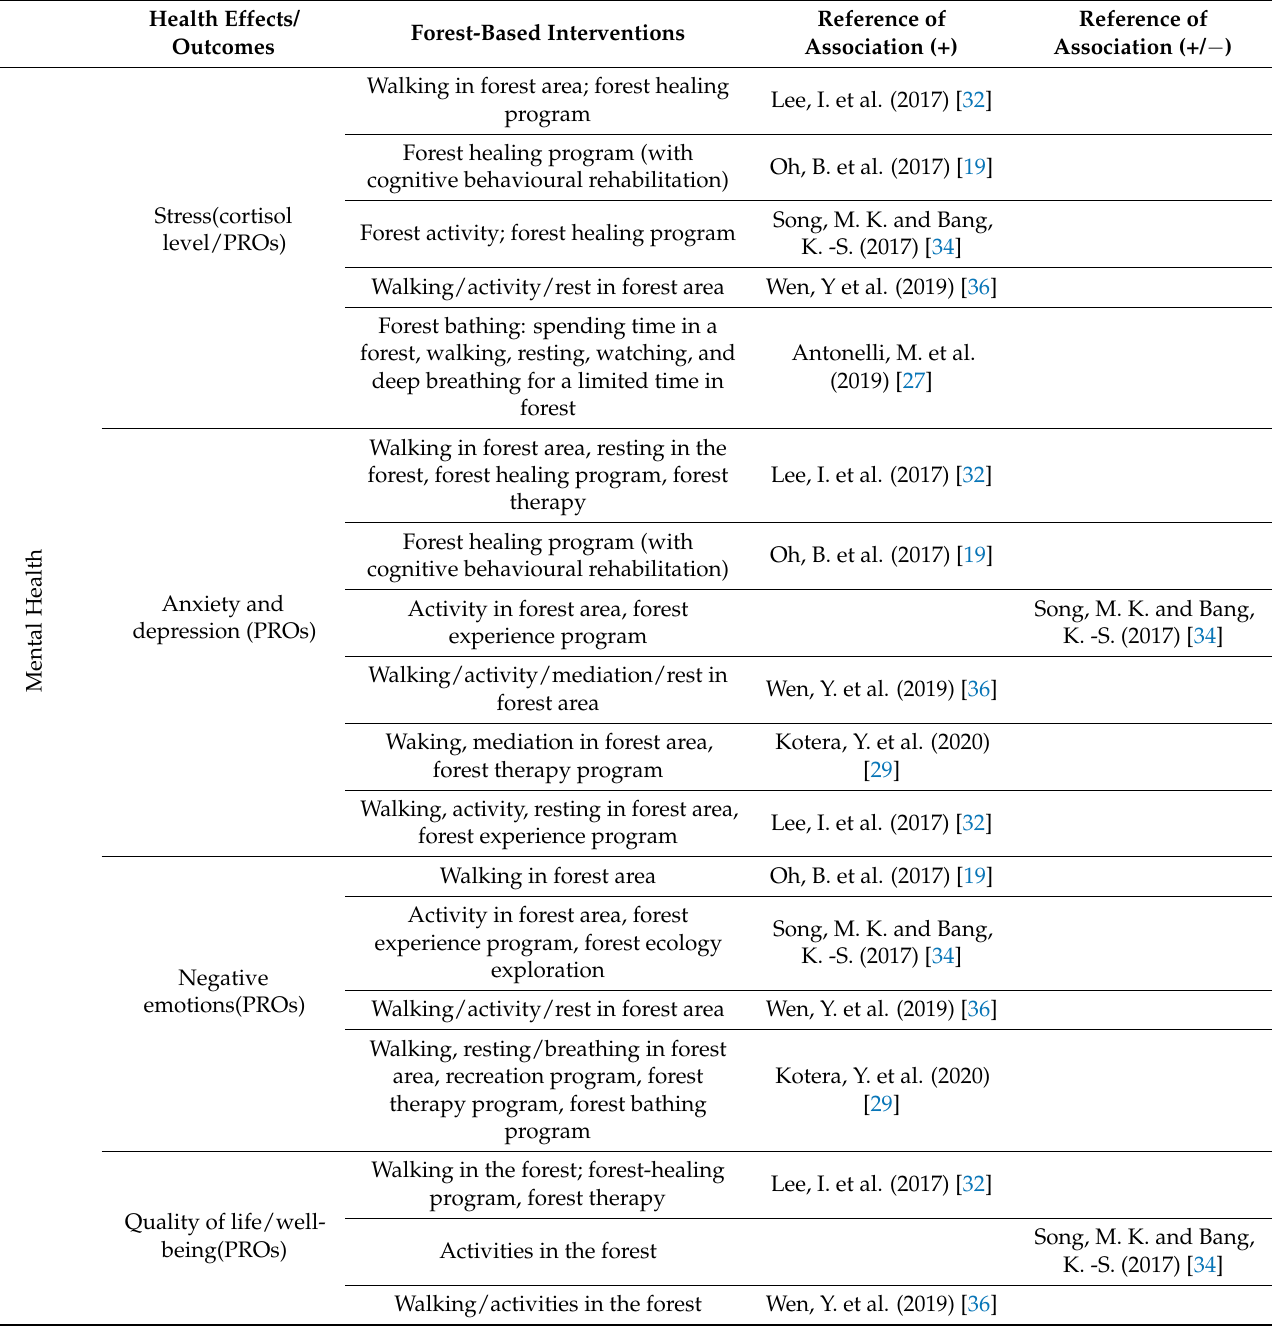
Table 7. Summary of associations between forest-based interventions and health effects/outcomes in mental health.